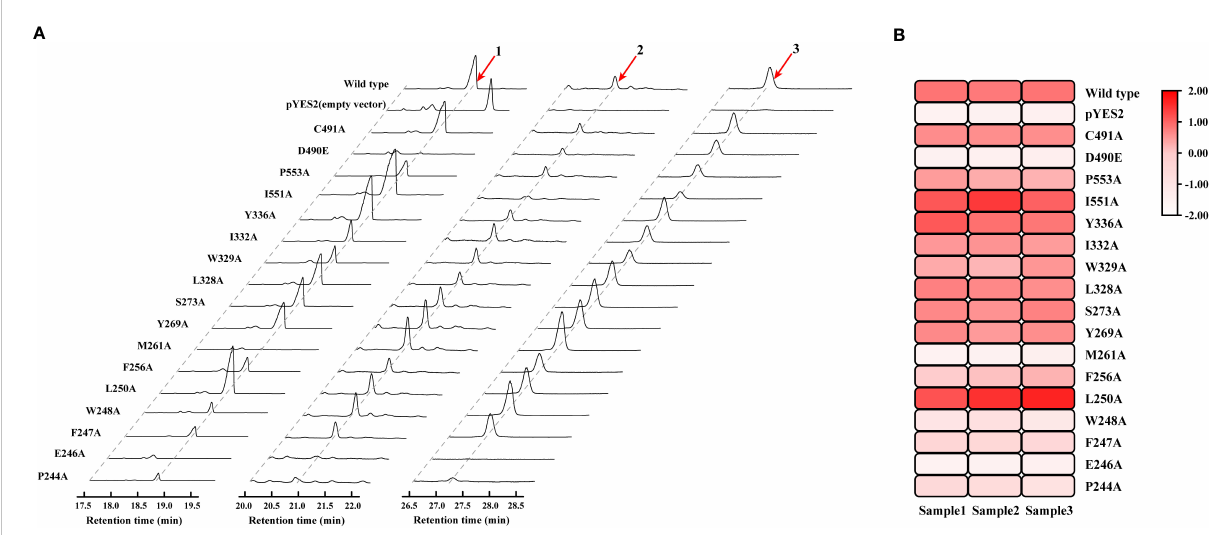
FIGURE 4 Mutagenesis-based alterations show residues that control substrate af fi nity of HcOSC6 and the catalysis activity for HcOSC6. (A) GC-MS analysis of yeast extracts expressing the wild type and mutant HcOSC6. Peak 1 is cucurbitadienol; Peak 2 is 25-Hydroxycholesterol,3-trimethylsilyl; Peak 3 is 5 b -Cholestane-3 a ,7 a ,12 a ,24 a ,25-pentol. (B) Heatmap of the cucurbitadienol conversion rates related to HcOSC6. The degree of redness indicates the conversion